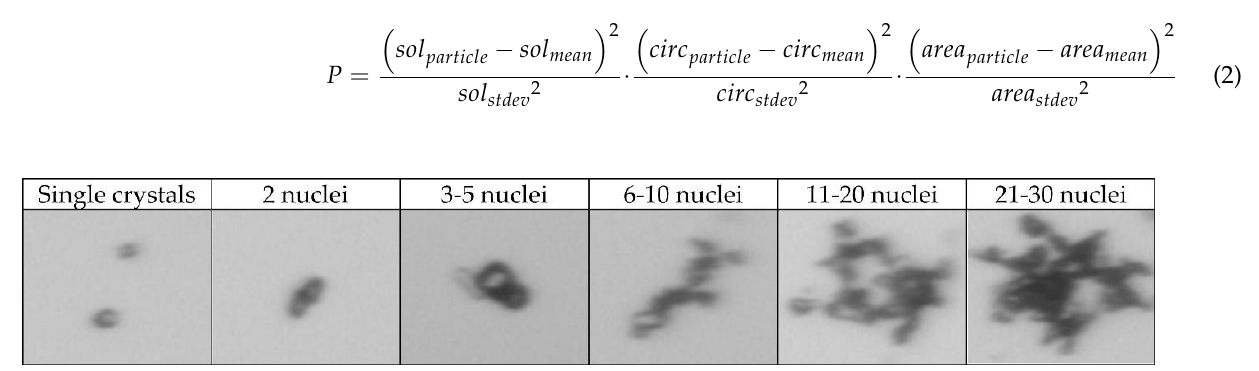
Figure 2. Particles used to calibrate the aggregation degree. The images are all 153 µm wide. Table 1. Classification of the particles into different categories according to the proposed method.